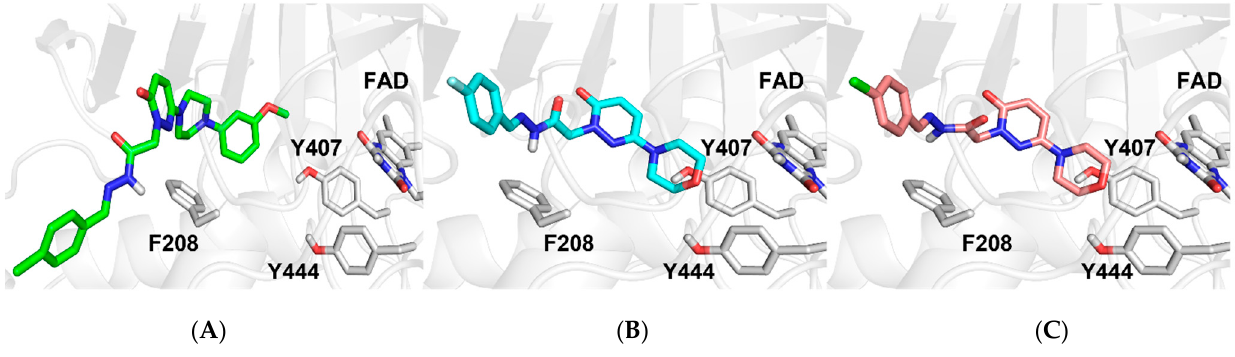
Figure 3. Zoomed in view at MAO-A binding site. Best poses of TR2 ( A ), TR15 ( B ), and TR16 ( C ) were reported as green, cyan, and magenta sticks, respectively. For completeness, docking scores returned from simulations were equal to − 7.99, − 8.29, and − 8.16 kcal/mol for TR2, TR15, and TR16, respectively.